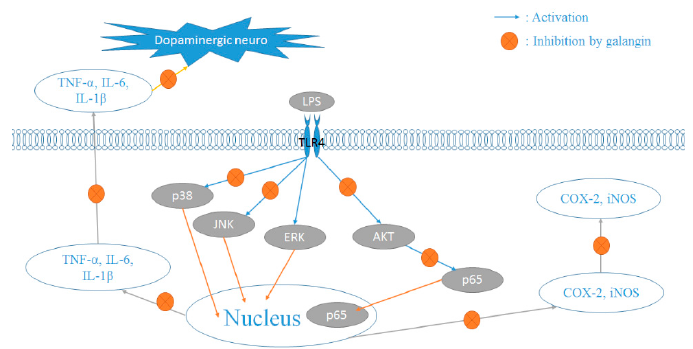
Figure 7. Galangin suppresses pro-inflammatory mediators in LPS-induced BV-2 cells via inhibiting the phosphorylation of the NF- κ B p65, AKT, p38, and JNK signaling pathways.